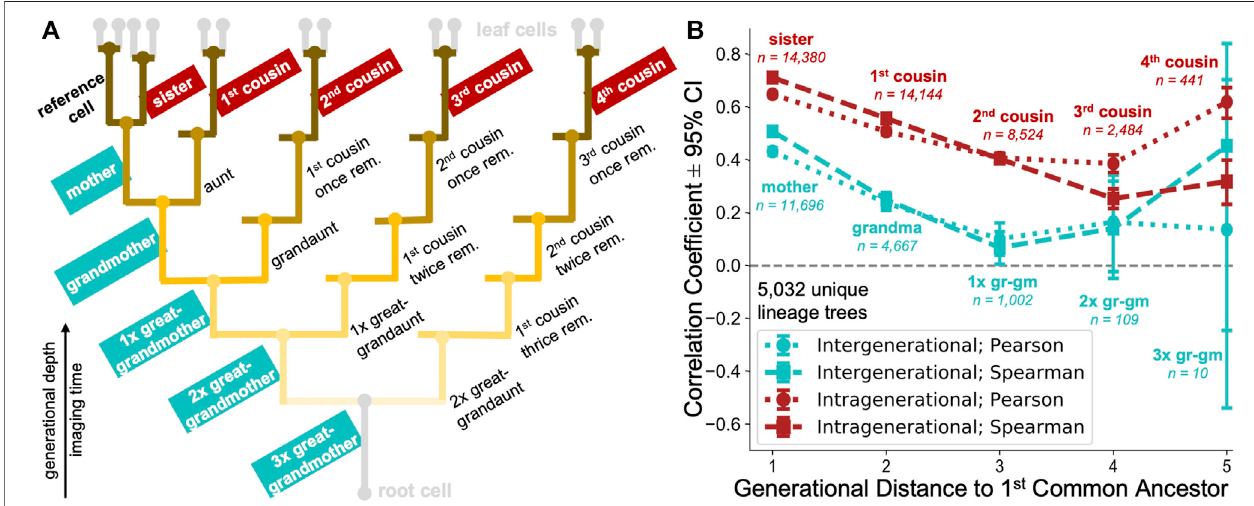
FIGURE8| Large-scale multigenerationalanalysisofsingle-cell cyclingdurations. (A) Illustrativelineage treeshowing20typesoffamily relationshipsofareference cell(bold)toitslineagerelativesdeterminedusingourautomatedapproach.Thetreecapturesextendedkinshipsonancestral(inter-generational;generationallyunequal) to fourth cousin span (intra-generational; generationally equal). Strength of the branch colour shading illustrates the generational distance to nearest common ancestor betweenfamilymember andreferencecell. (B) Cyclinglengthcorrelations incelllineages. intra-generational(red) correlations appeartobeconsistently higherthan the inter-generational (cyan) correlations in directly ancestral branches. Pearson (dotted) and Spearman (dashed) rank correlation coef fi cients with 95% con fi dence interval (CI) are shown for selected relationship pairs as in the lineage tree schematic, categorised according to the generational distance to fi rst common ancestor.